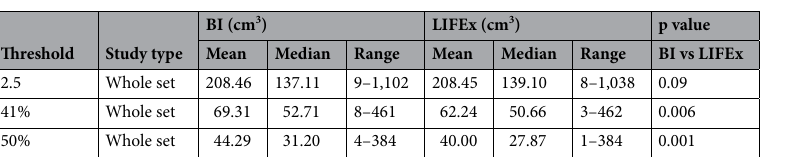
Table 2. Study for the whole set of patients without considering the number of lesions they had. Contouring performed using BI and LIFEx. P values compared the mentioned pair of data.